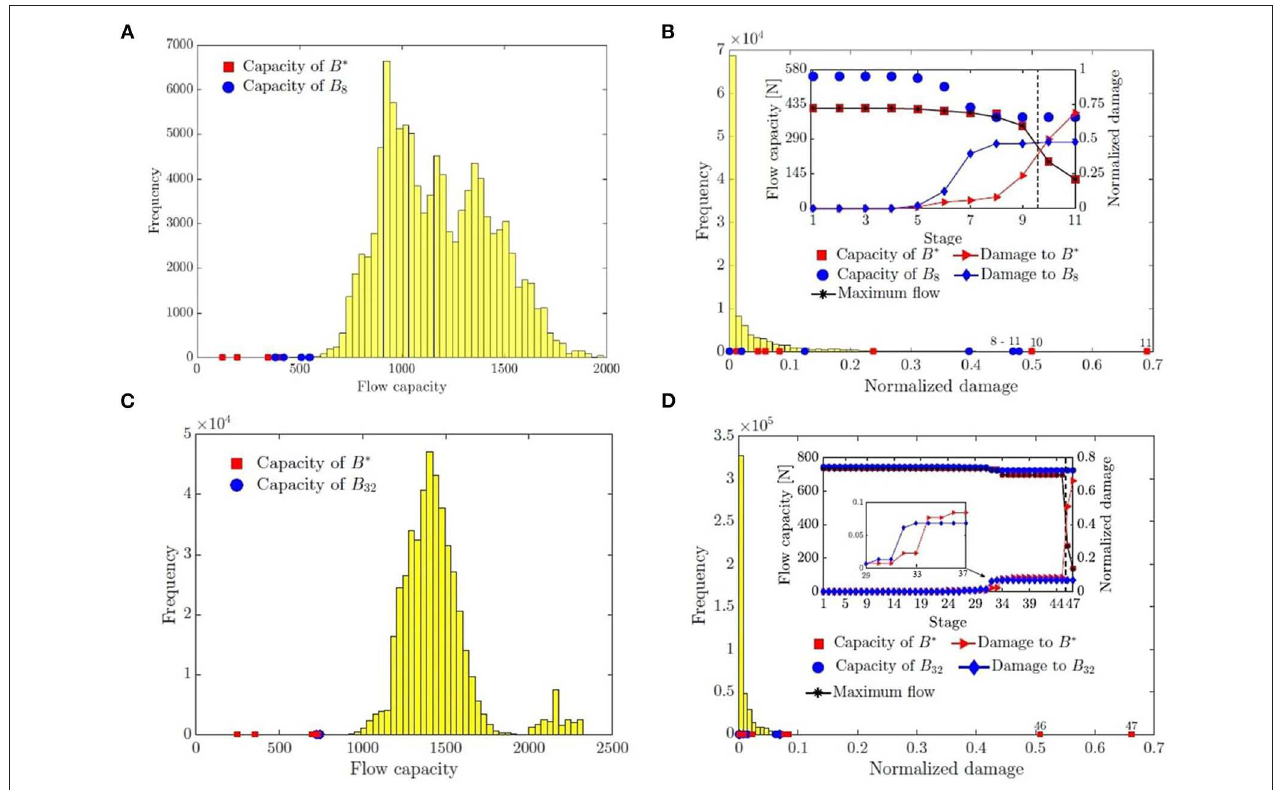
FIGURE 11 | (Color online) Fracture strength of force bottlenecks. (A,B) DI and (C,D) DII. Frequency distribution of: (A,C) the capacities of 10,000 random cuts of N ; and (B,D) their normalized damage across all observed stages of loading. The capacities of the primary bottleneck B ∗ (secondary bottleneck) are marked by the red squares (blue circles). Normalized damage in a given bottleneck is the number of broken bonds relative to the initial number of bonds at stage 1. Inset shows coevolution of the fracture strength of, and damage in, the bottlenecks. Dashed vertical line marks the stage at peak